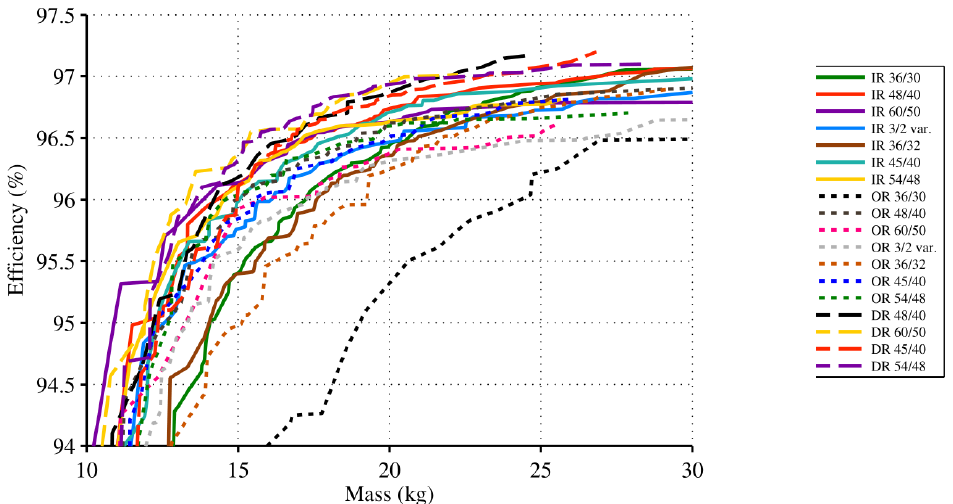
Figure 5. Edges of Pareto optimal fronts for design of the NASA SCEPTOR electric propulsion system. In the legend, IR indicates inrunner, OR indicates outrunner, and DR indicates double runner. The ratios in the legend are the number of stator slots to the number of rotor poles (stator slots / rotor